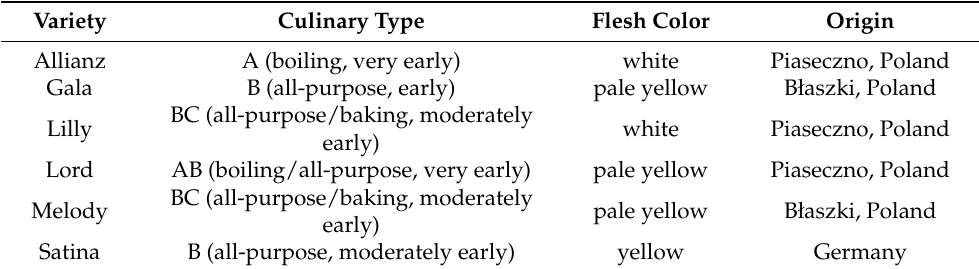
Table 1. Potato varieties used in this study. Variety Culinary Type Flesh Color Origin Allianz A (boiling, very